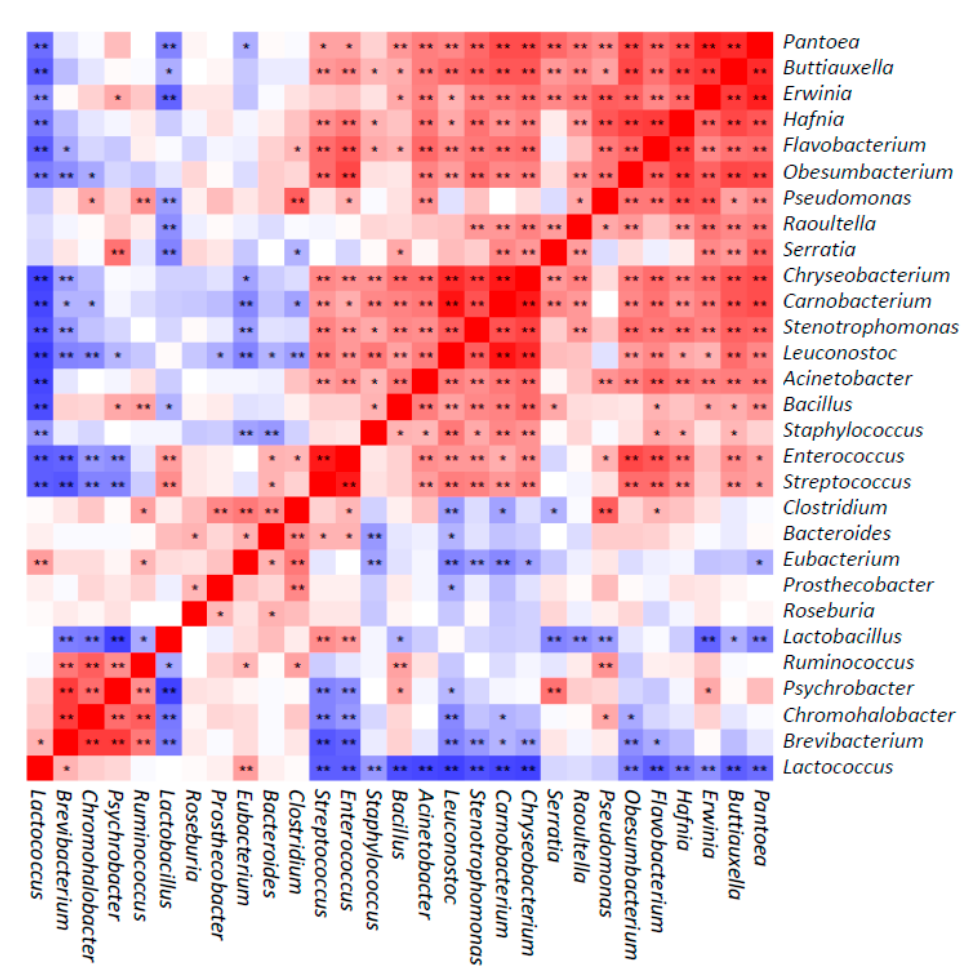
Figure 3. Spearman’s rank correlations between main bacterial genera found in Idiazabal cheese samples. Significant correlations are represented by ** p ≤ 0.01 and * p ≤ 0.05.